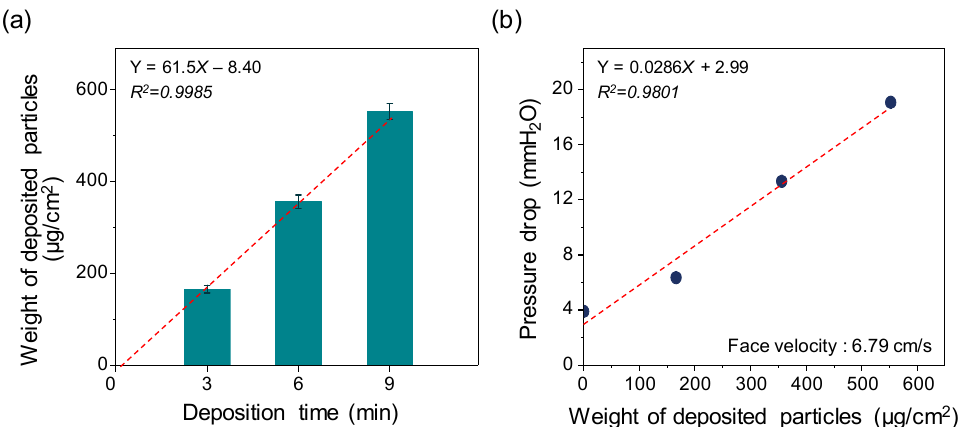
Figure 3. ( a ) The weight of deposited NSS particles under various deposition times, and ( b ) pressure drop through the filters under various deposition weights. Error bars indicate standard deviation ( n = 3).